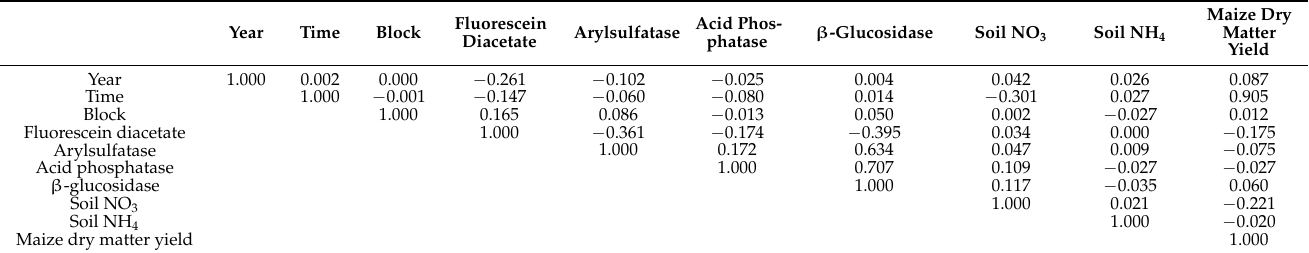
Table 9. Pearson’s correlation coefficients among soil enzyme activity, soil nitrogen, and maize dry matter yield ( n =